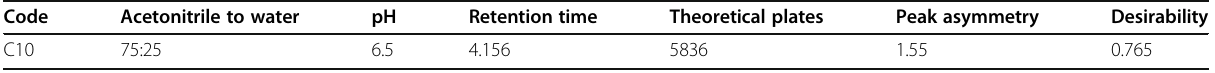
Table 3 Obtained solution for optimized formulation Code